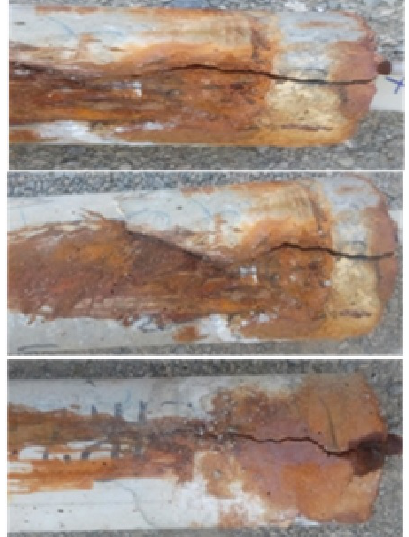
Fig. 4. Cylinder samples with crack after